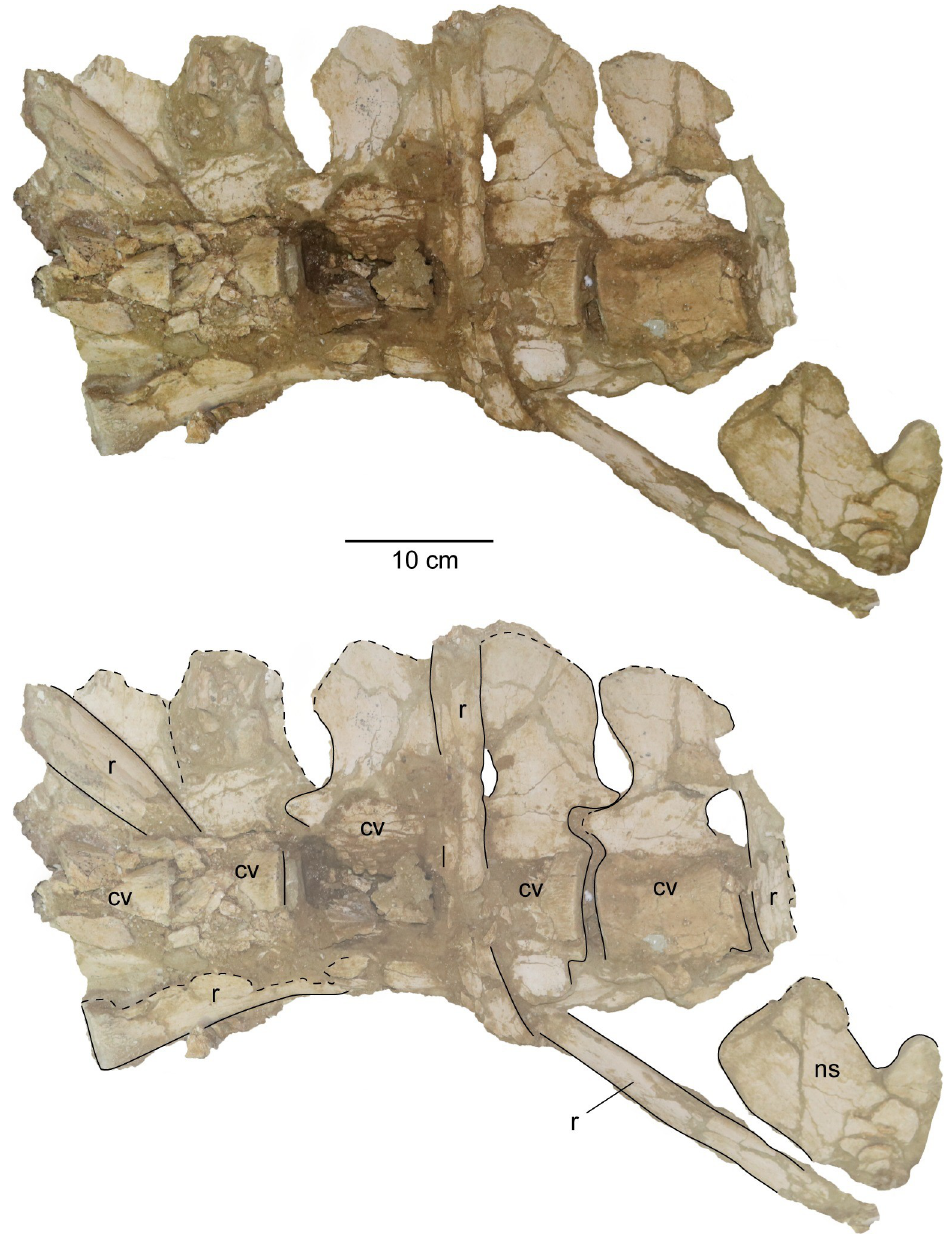
Fig 27. Posterior cervical series from the holotype of Cardiocorax mukulu (MGUAN PA103). The anteroposteriorly elongated neural spines nearly touch adjacent neural spines and form a sinusoidal anterior margin that in combination with other characters is diagnostic of Cardiocorax mukulu